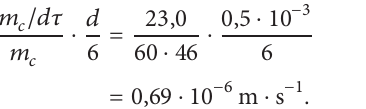
Figure 1: Sketch map of TG heating vessel and laboratory device MOM Budapest, type 3427. 1: cup with sample measured; 2: cup